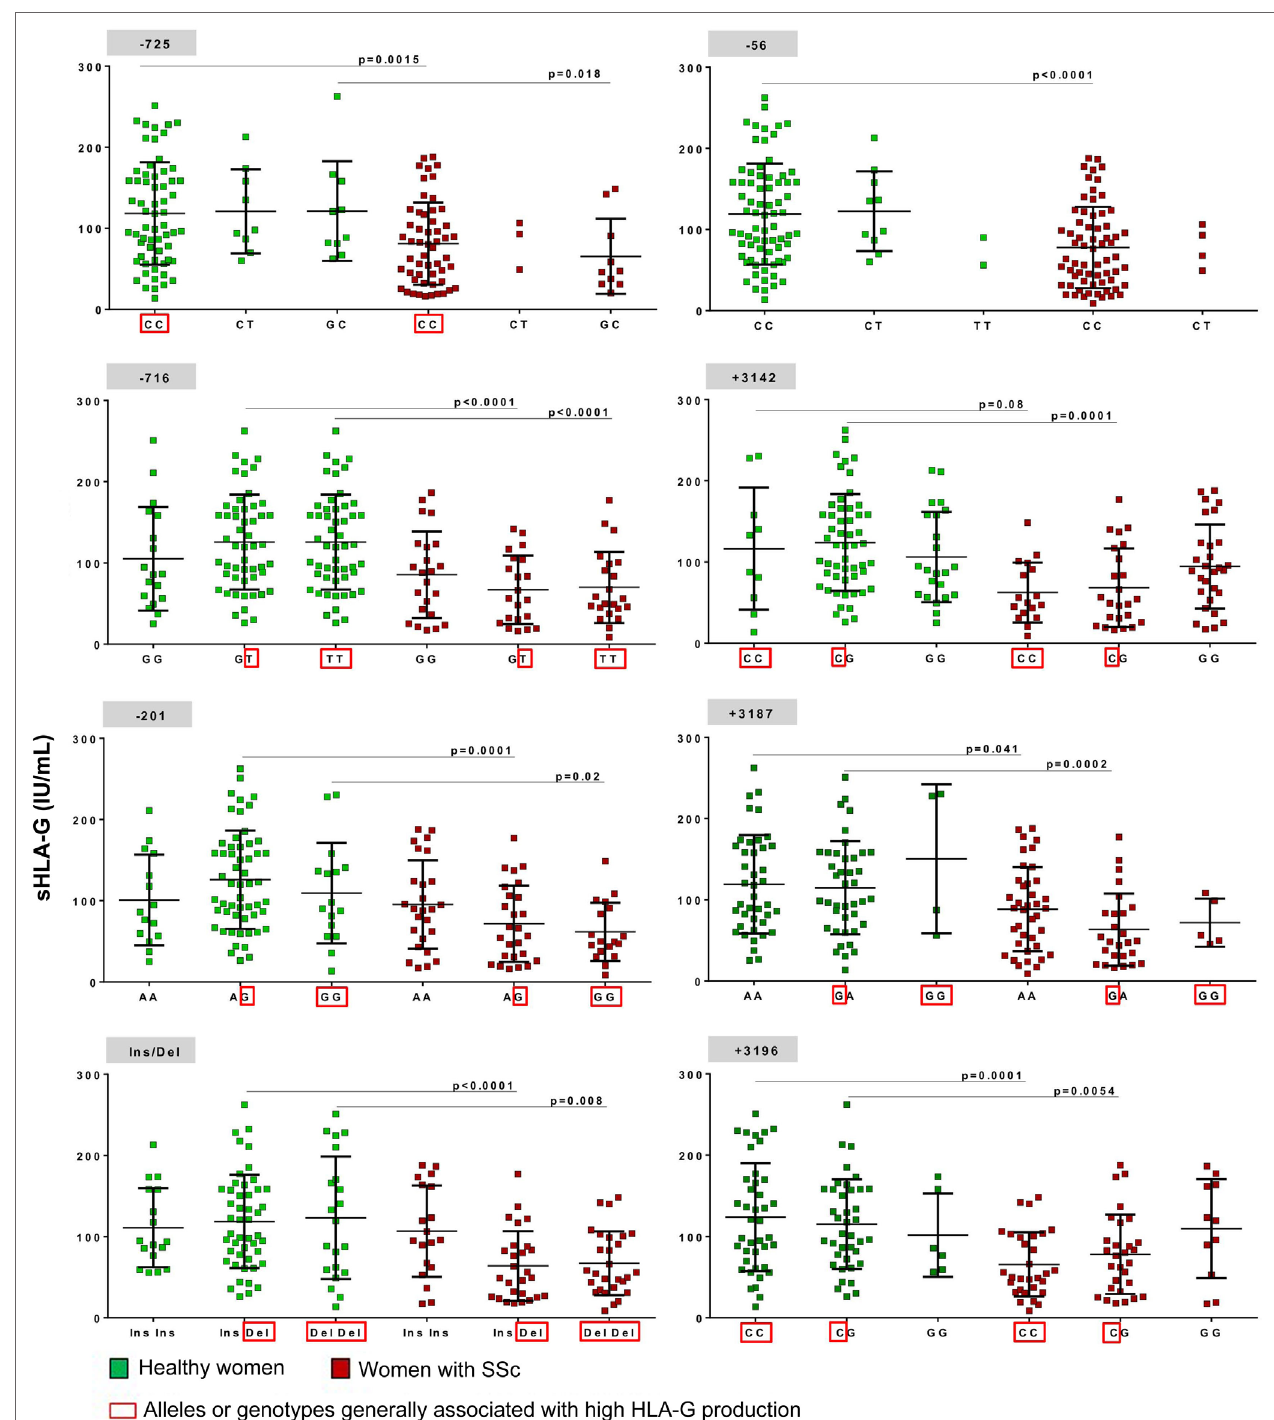
FigUre 3 | Concentration of soluble HLA-G (sHLA-G) per mL of plasma according to different human leukocyte antigen (HLA)-G genotypes. The eight polymorphisms tested ( − 725, − 716, − 201, − 56, Ins/Del, + 3,142, + 3,187, and + 3,196) are represented with their three possible genotypes (i.e., GG, GT, and TT for − 716 SNP) except for − 725 SNP for which six genotypes exist: CC, CT, GC, TT, GG, and GT but the last three were not represented on the graph as only few women had these genotypes; sHLA-G concentration values are represented for each genotypes in green (on the left side) for healthy women and in red (on the right side) for women with SSc. A red square is surrounding alleles or genotypes having been described in most studies with high HLA-G production. Means and SDs are given for each scatter plot by black bars. P values are calculated by Mann–Whitney tests.